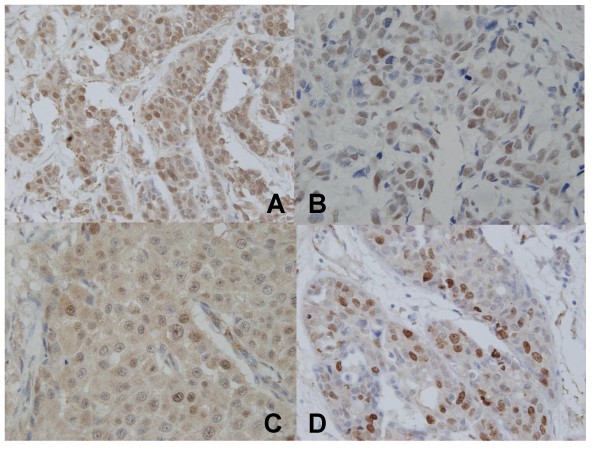
CENP-F (A) and Ki67 (D) exhibited immunohistochemically positive staining of nucleus in invasive ductal cancer of the breast. CDC6 revealed 2 patterns of nuclear and cytoplasmic expressions in invasive ductal carcinoma of the breast. Positive nuclear and cytoplasmic stainings of CDC6 are presented in (B) and (C), respectively.